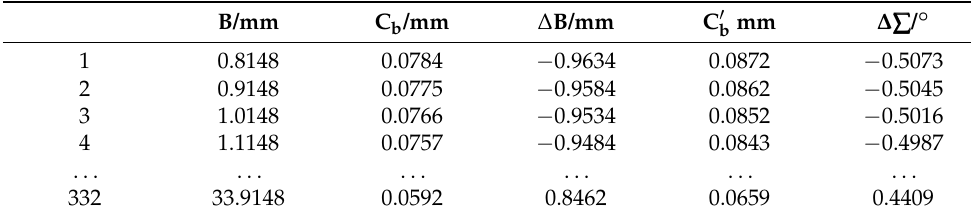
Table 6. Partial data of skiving tool path.